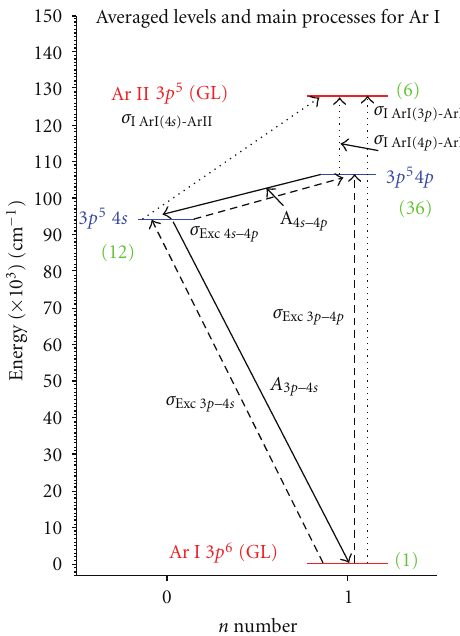
Figure 2: Grotrian diagram for averaged levels of Ar I and Ar II. 1 to 15, the configuration and core description (c/c), the n and l quantum numbers, the jK and LS terms